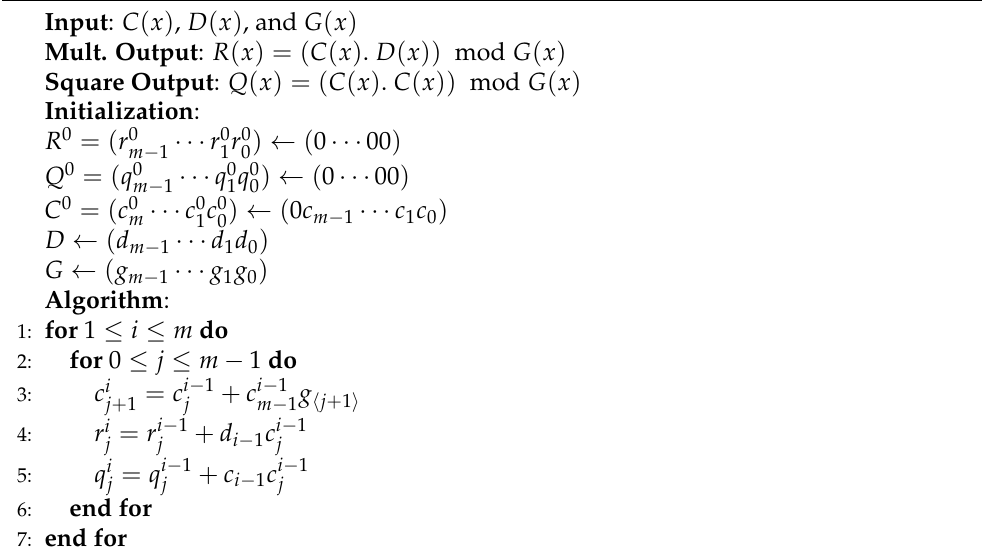
Algorithm 2 Bit-level algorithm for multiplication and squaring over GF(2 m